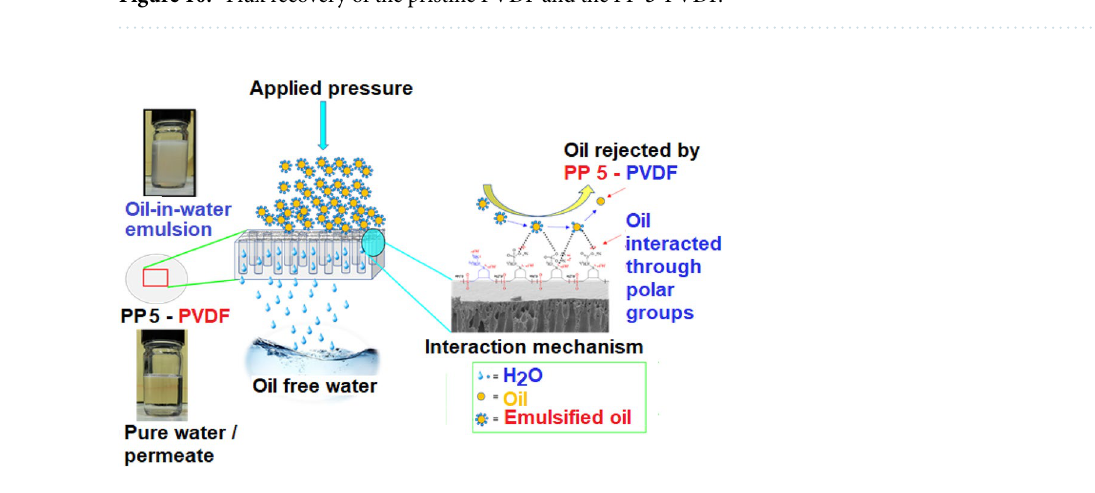
Figure 10. Flux recovery of the pristine PVDF and the PP- 5 -PVDF.